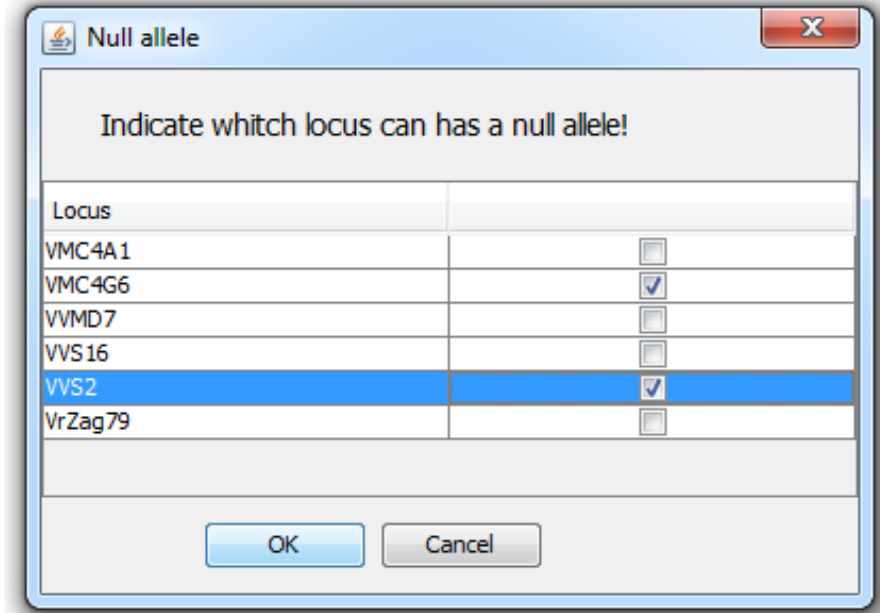
Figure 3. Input dialog to indicate which loci have a null allele.